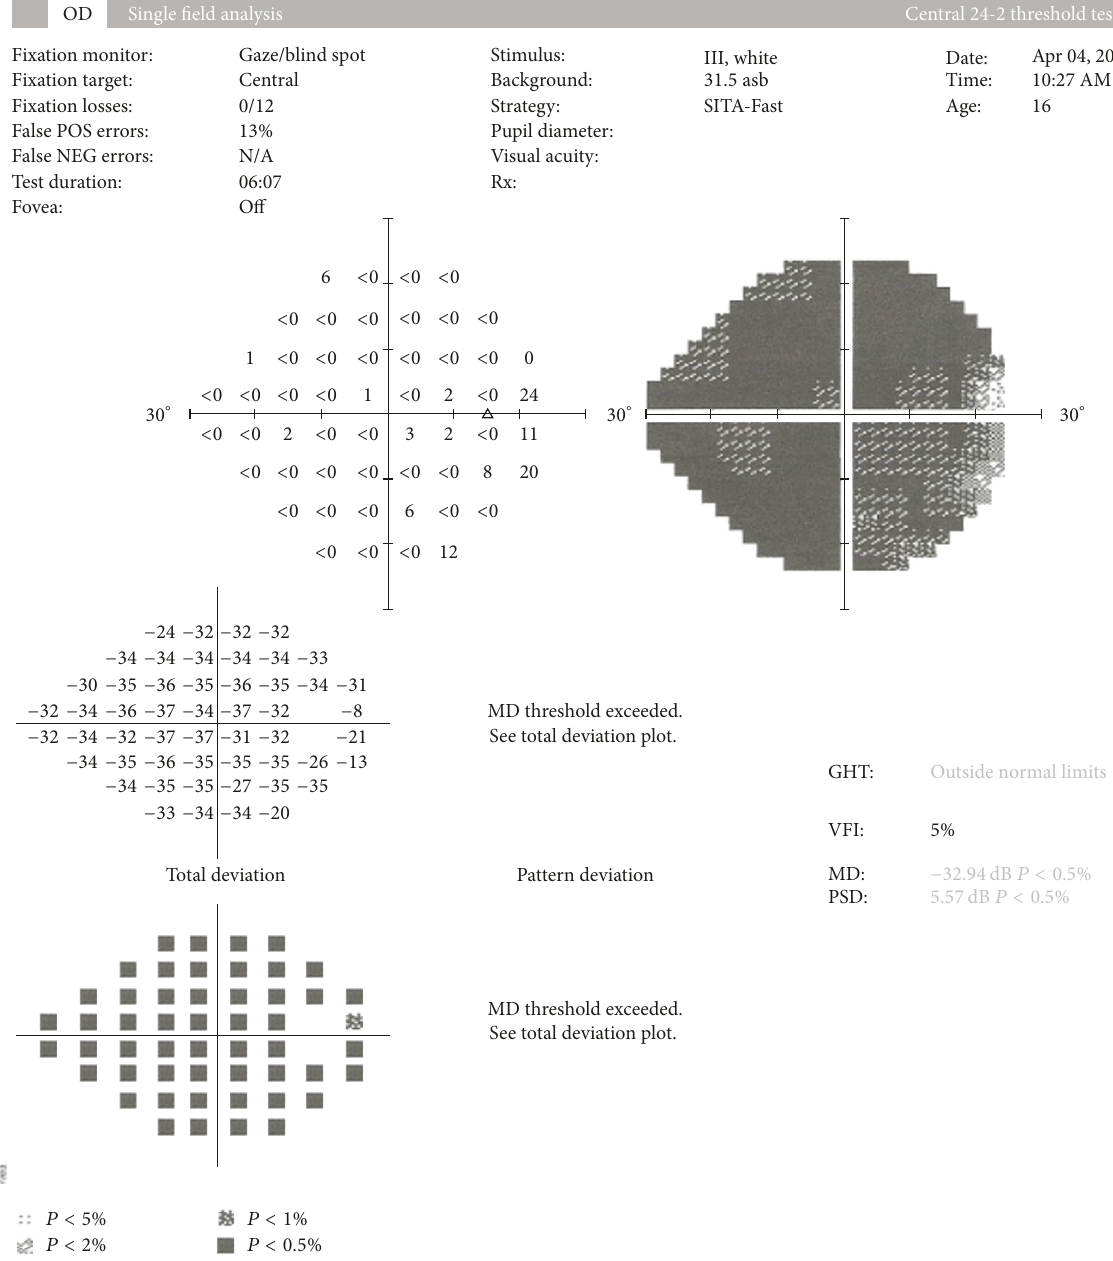
Figure 3: Humphrey’s visual field analysis showing advanced glaucomatous visual field loss in his right